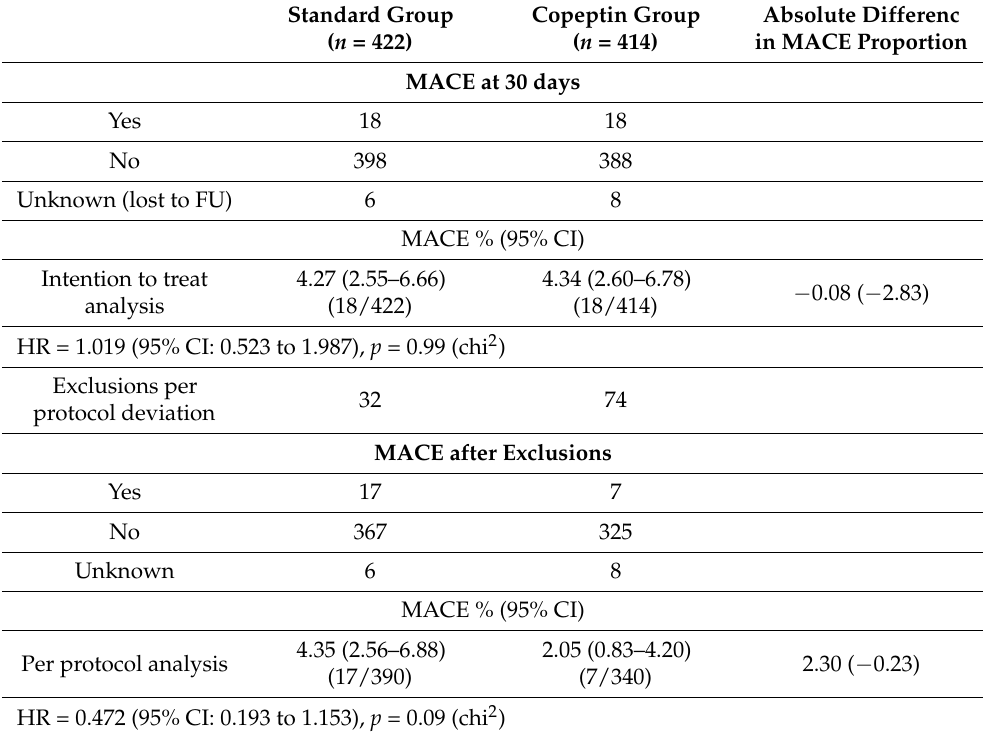
Table 2. Primary endpoint